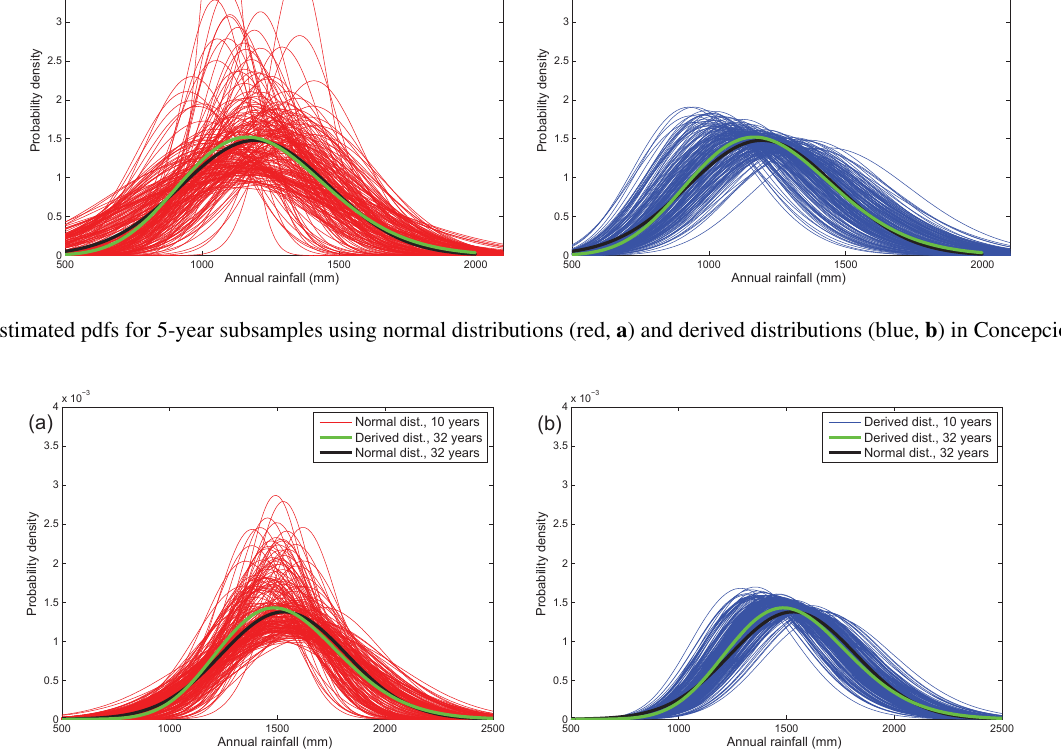
case the mean and standard deviation of 200 samples are pre-